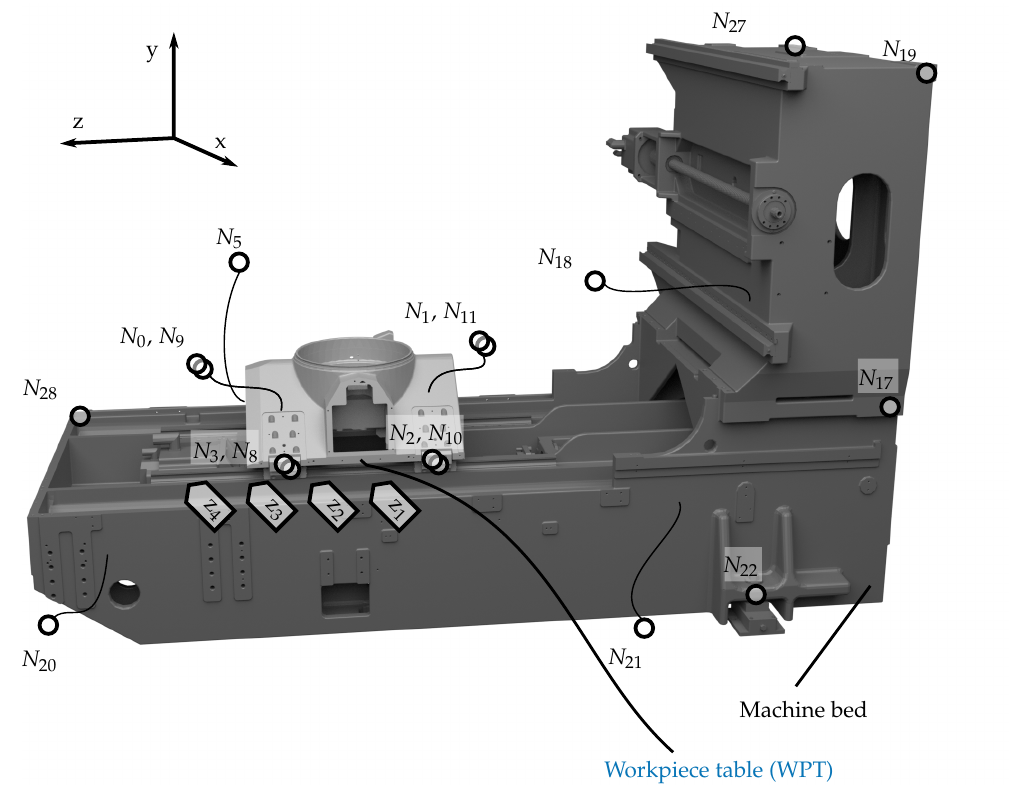
Figure 7. Rendering of the considered machine tool, the measurement positions z 1 to z 4 , and the measured nodes; the WPT is depicted in position z 3 and a description of the node points can be found in Table